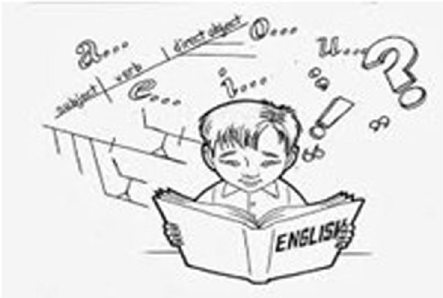
Fig. 1 G1 ’ s original metaphorical representation. This fi gure shows that the learners believe that the textbook is the basic source of learning a language.